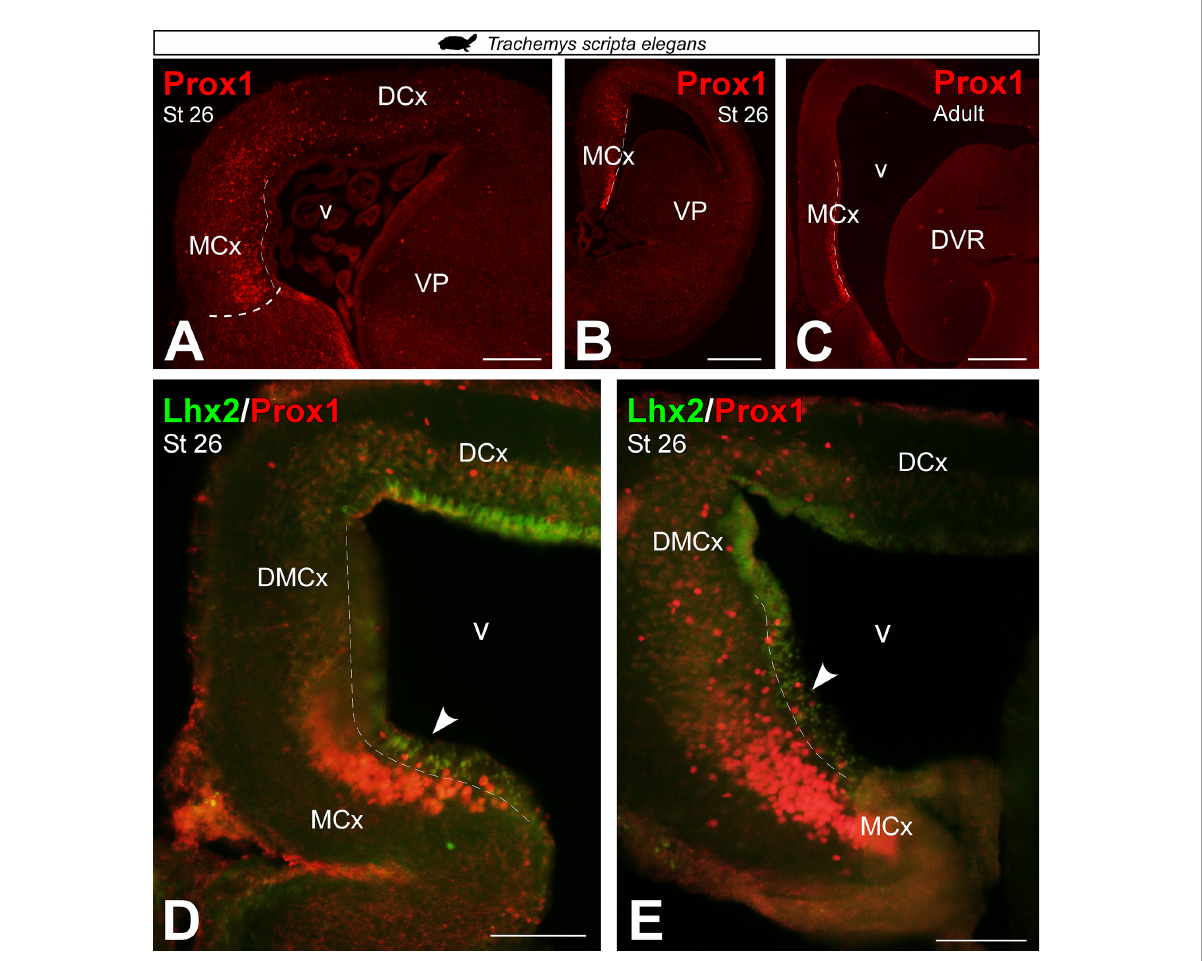
FIGURE7 Photomicrographs of transverse sections through the telencephalon of Trachemys scripta elegans showing, from rostral to caudal levels, Prox1 expression (A–C) and its combination with Lhx2 (D,E) . In each panel, the developmental stage and the color code for the used markers are indicated. Filled arrowheads point to ventricle-expressing cells. Scale bar in panels (A,C,D,E) = 200 µ m and (B) = 500 µ m. See the abbreviation